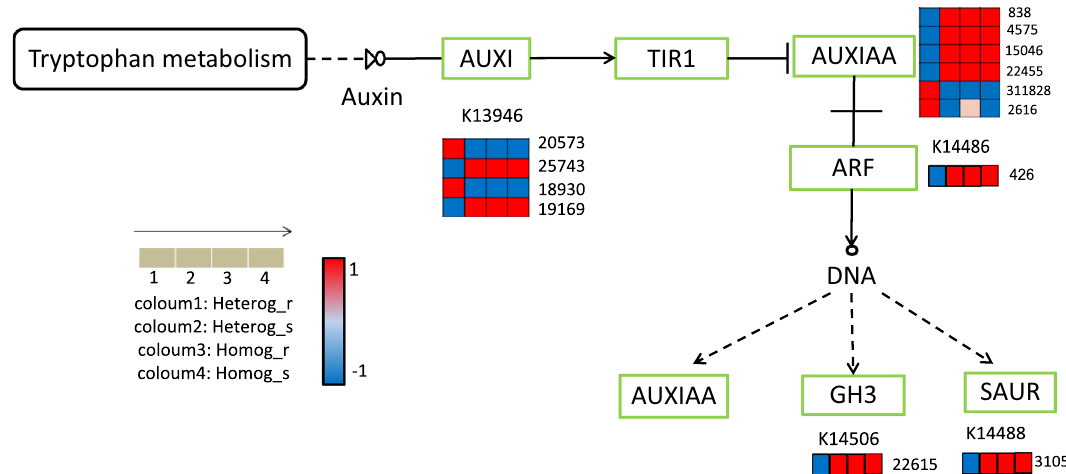
Figure 11. Different genes expressed in auxin related